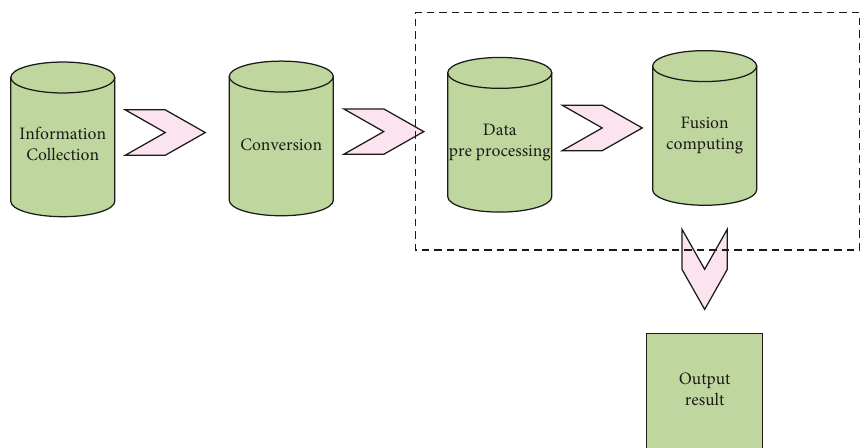
Figure 3: Fusion